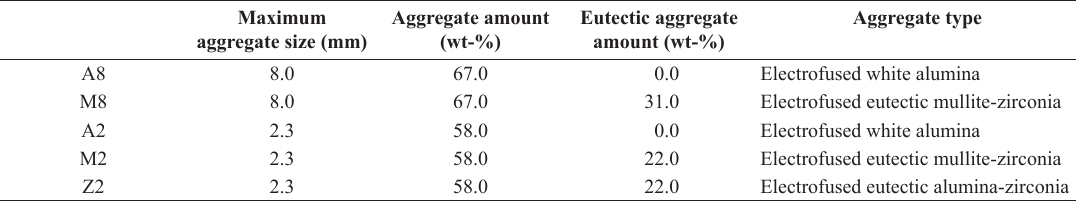
Table 1. Formulation of the five refractory castables.